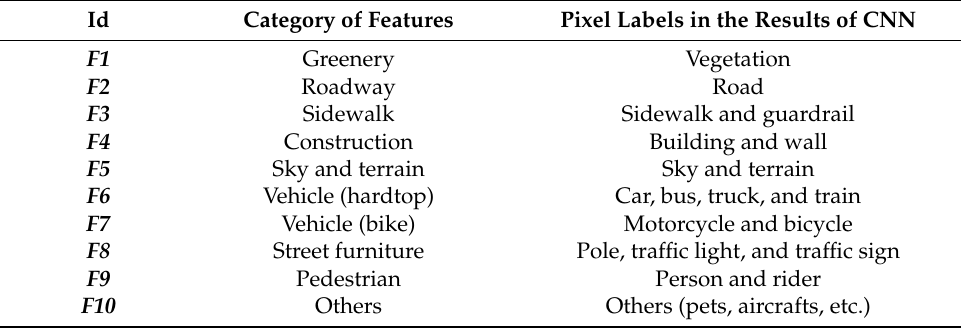
Table 1. Mapping semantic features from the results of transfer